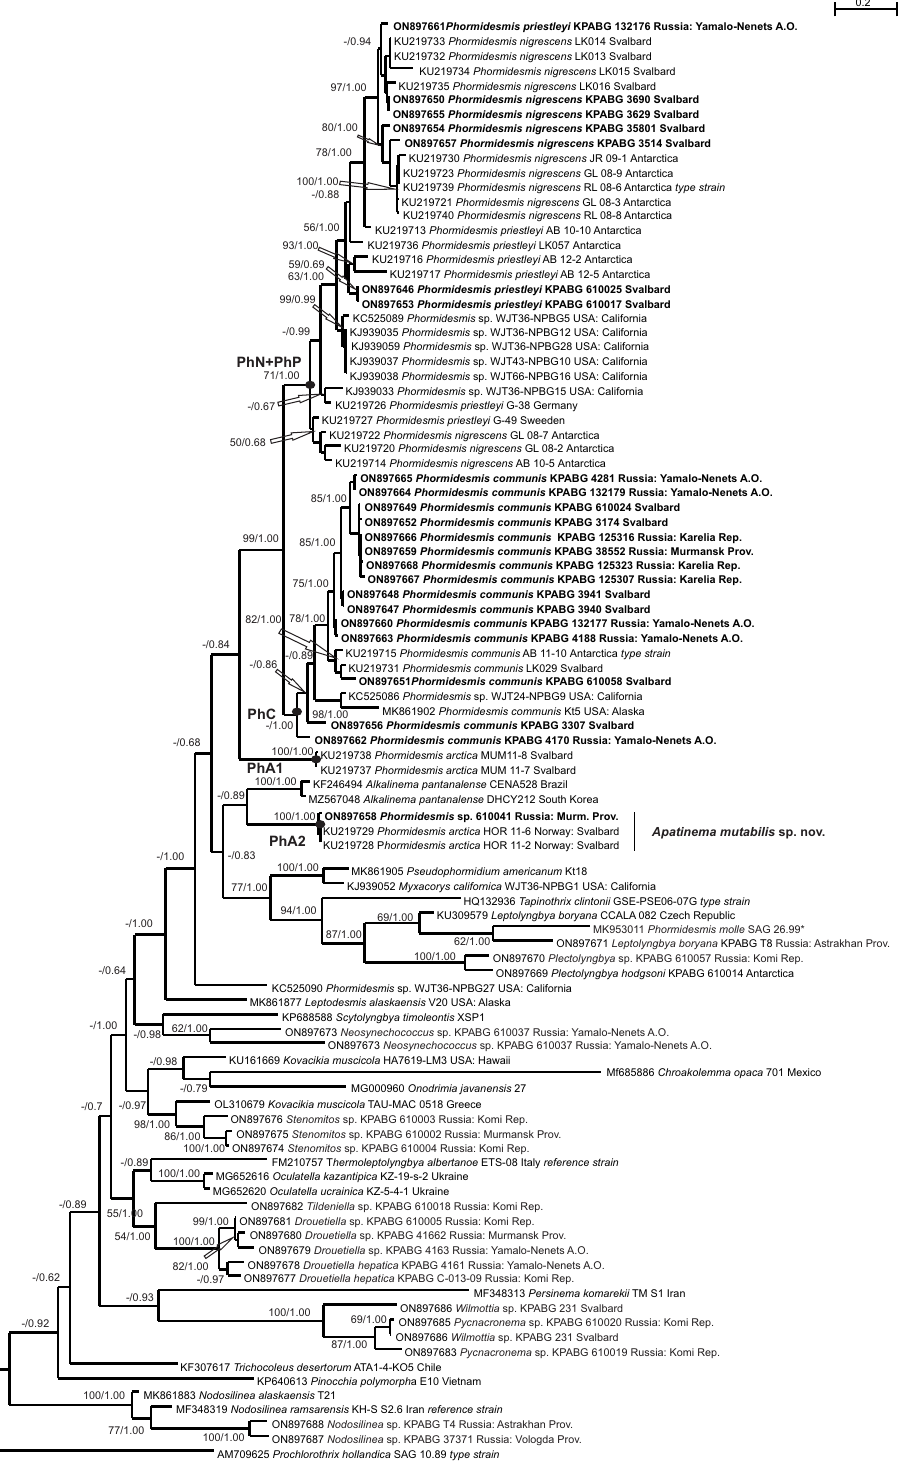
Figure 3. Phylogram obtained under the Bayesian approach for 99 accessions of Leptolyngbyaceae and related taxa based on 16S rRNA gene and 16S–23S ITS. Bootstrap support values from maximum likelihood and Bayesian posterior probabilities more than 50% (0.50) are indicated. The strains sequenced in the current study are in bold, accessions of Phormidesmis molle are marked by an asterisk. PhA1— Phormidesmis arctica clade 1, PhA2— Phormidesmis arctica clade 2, PhC— Phormidesmis communis , PhN— Phormidesmis nigrescens , PhP— Phormidesmis priestleyi